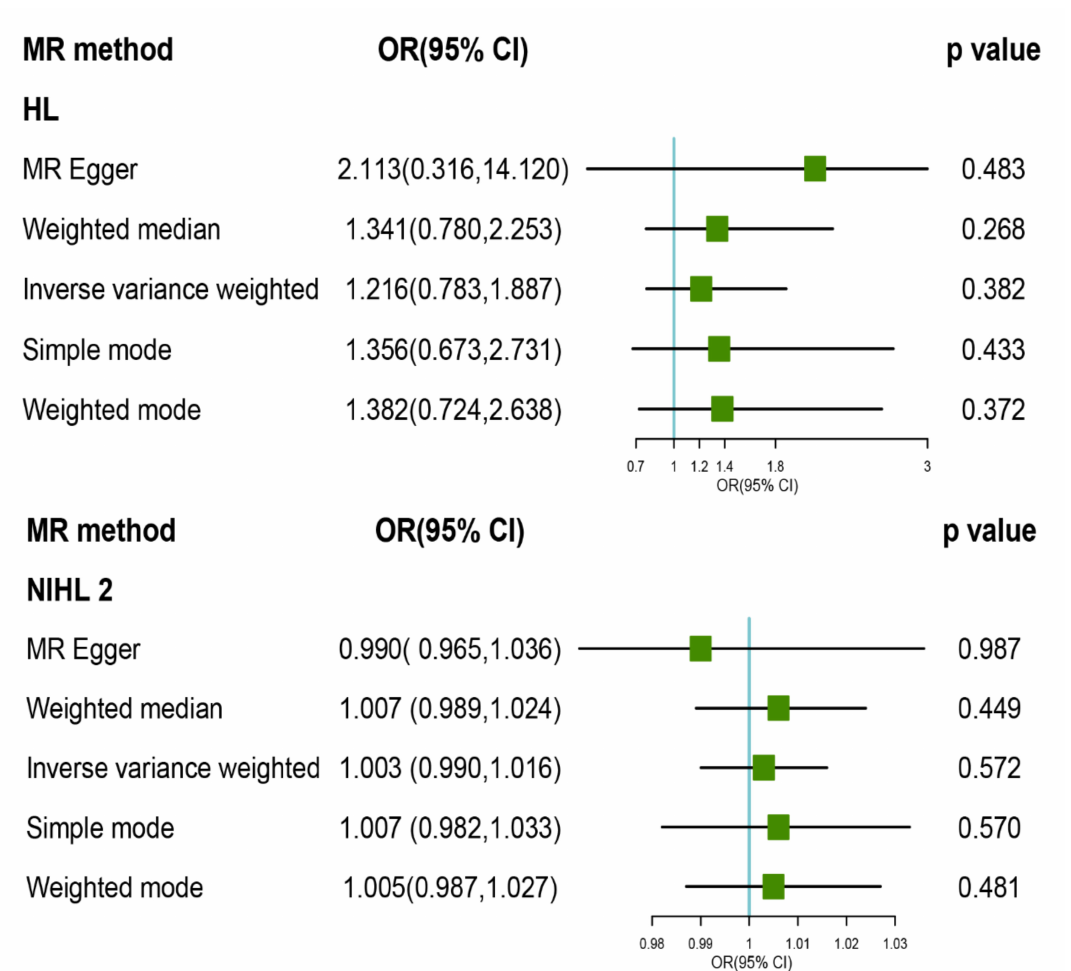
Figure 2. Mendelian randomization (MR) results for telomere length and hearing loss (HL) and its subtypes. OR: odds ratio; CI: confidence interval; HL: all hearing loss; ARHL: age-related hearing loss; NIHL: noise-induced hearing loss. A, HL; B, ARHL; C, NIHL; D, NIHL excluding the following four heterogeneous sites: rs2736176, rs3219104, rs8105767, and rs2302588